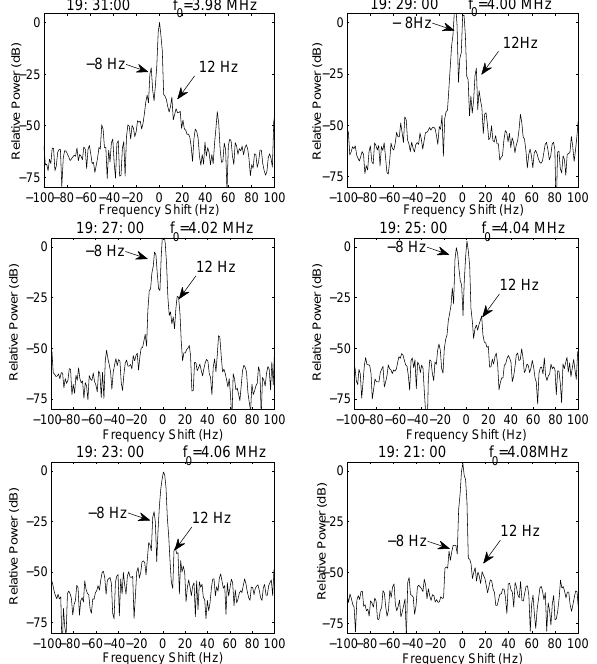
Figure 1. Narrowband SEE frequency spectra of HF scattered sig- nals showing strong emission lines at 8–12Hz using the EISCAT HF transmitter operating at varying pump frequencies near 3 f c e during 19:20–19:32UT on 3 July 2012. The heating beam points towards the magnetic zenith direction with 1min on/off duty cycle.